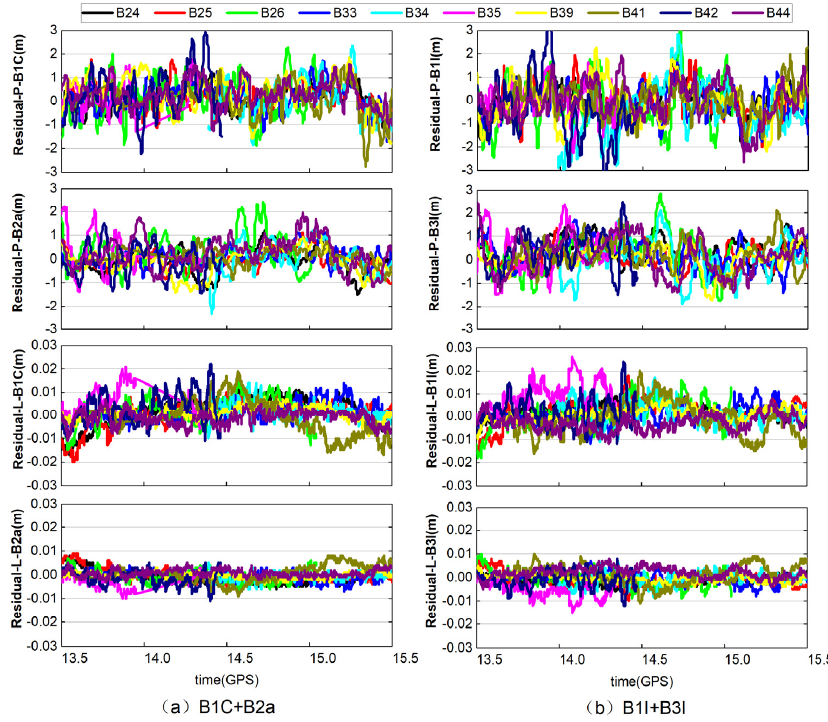
Figure 5. ( a ) The residuals of pseudo-range and phase observations for B1C+B2a combination of BDS-3 in WH04-HG02. ( b ) The residuals of pseudo-range and phase observations for B1I+B3I combination of BDS-3 in WH04-HG02. Table 3. The RMS of double-difference solutions from different combinations of BDS-3 in WH04- HG02 (m).